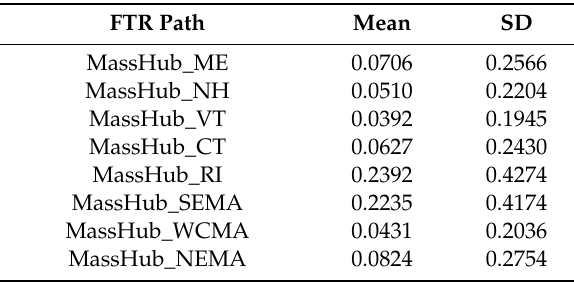
Table 1. Summary statistics of profitable onpeak days for FTR path in 2019.